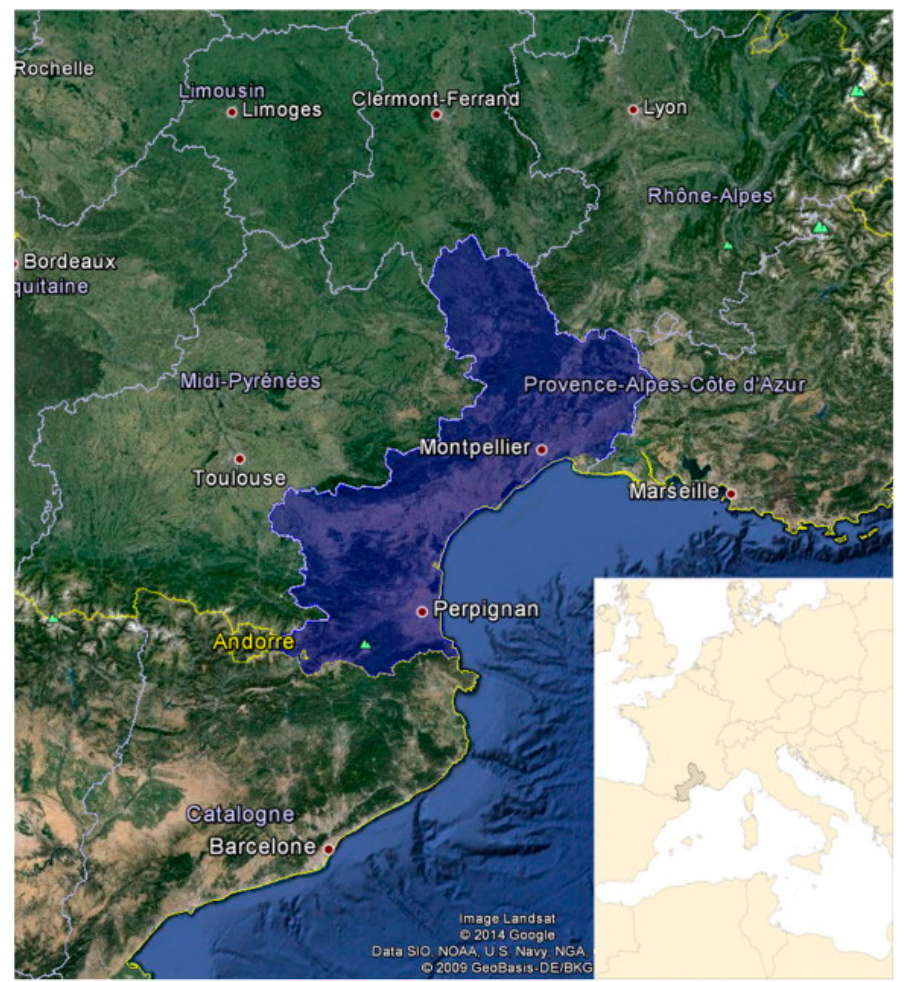
Figure 3. Location of the study area .